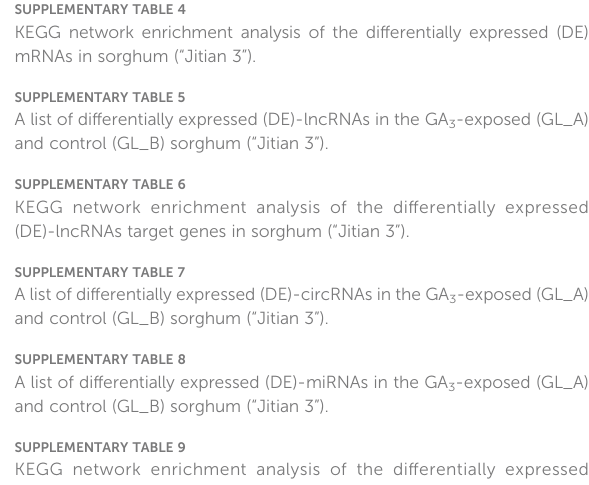
SUPPLEMENTARY TABLE 4 KEGG network enrichment analysis of the differentially expressed (DE) mRNAs in sorghum ( “ Jitian 3 ” ).